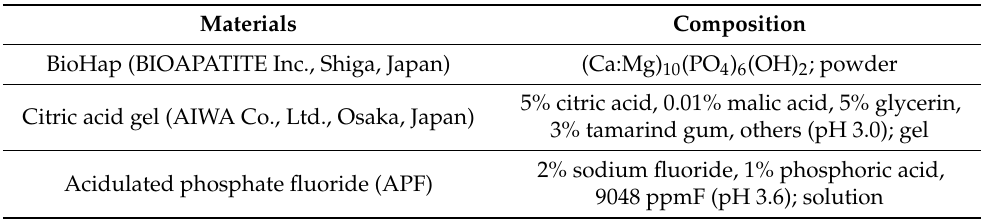
Table 1. Materials used in this study. Materials